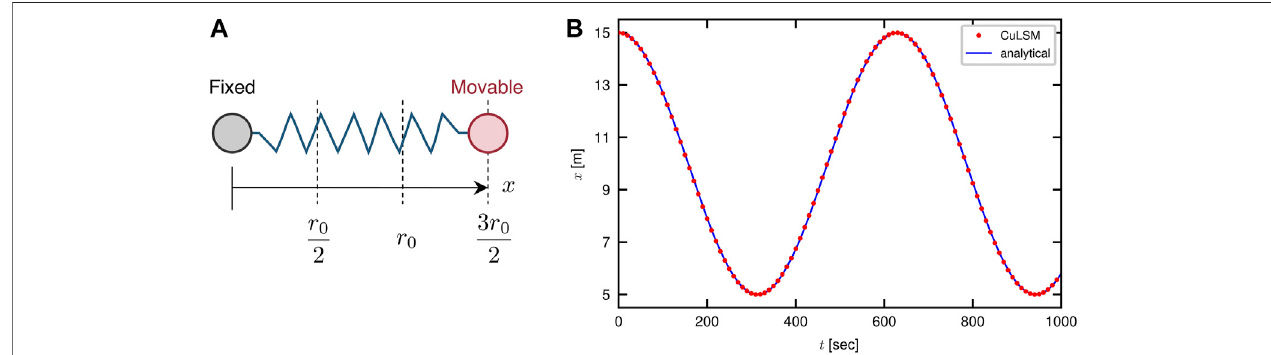
FIGURE 3 | Validation of CuLSM against the analytical solution of a simple harmonic oscillator. (A) Boundary and initial conditions of the oscillator. (B) Trajectory computed by CuLSM compared to analytical solution.